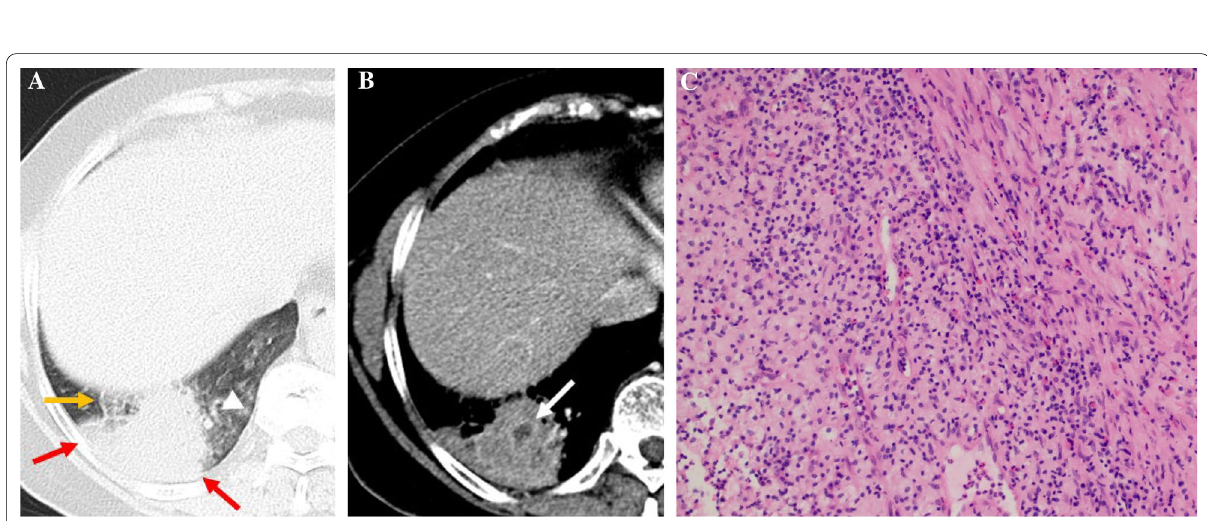
100) confirmed nonspecific inflammation ×